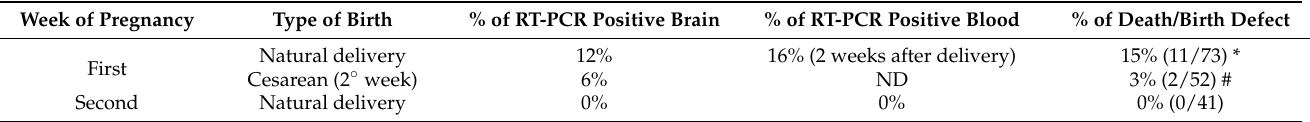
Table 1. USUV-positive brains and blood from babies born from experimentally infected mothers. Viral RNA was detected by quantitative RT-qPCR targeting the USUV NS5